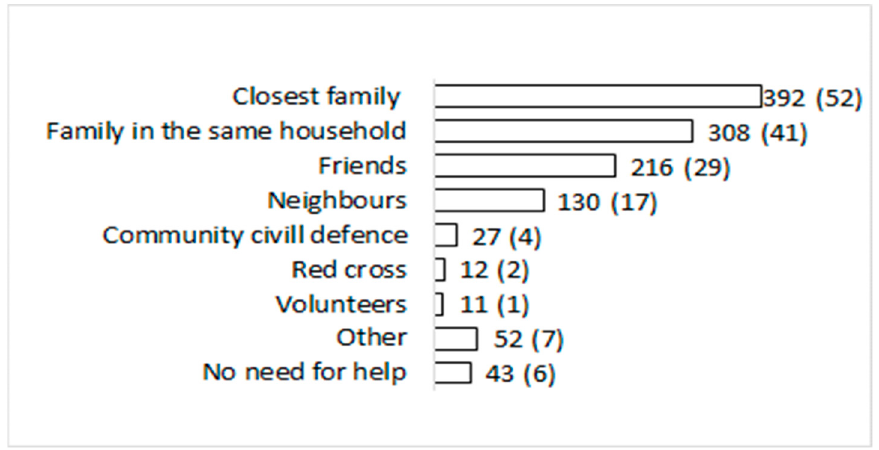
Figure 1. Caregivers and supporters for SARS-CoV-2 notified cases during isolation in the first pan- demic wave; No. (%). pandemic wave; No. (%).